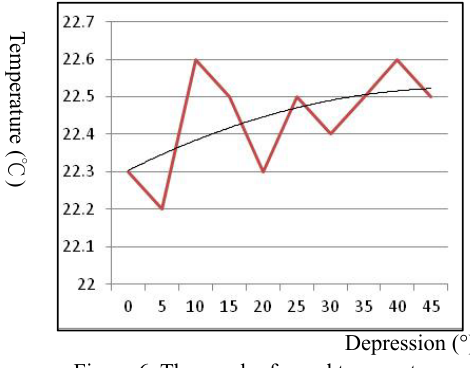
Figure 6. The graph of wood temperature